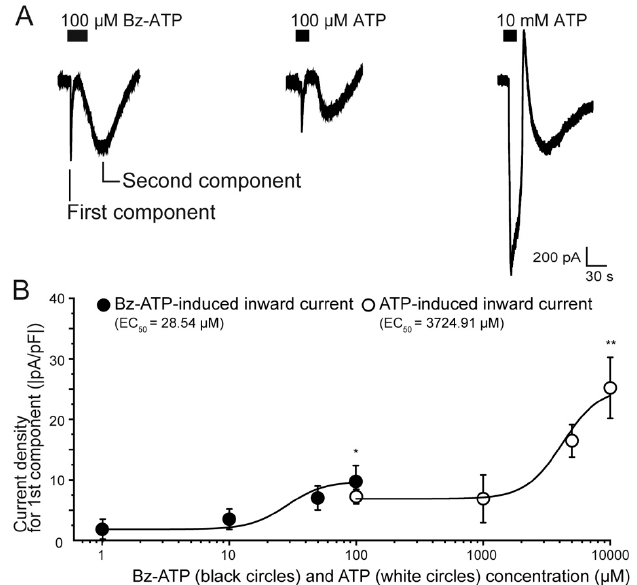
Figure 1. Characterization of primary cultured TG neurons. ( A ) Traces illustrate whole-cell currents evoked by a sequence of 10-ms depolarizing voltage pulses at Vh of − 60 mV in 10 mV increments from − 80 to +100 mV. The upper traces show the voltage pulse protocol. The middle traces were obtained from the cell in which the voltage-dependent inward currents were generated, and the lower traces were the cells in which the inward currents were not observed. Cells in which the generated inward current was observed were identified as neurons in the TG cells. ( B ) Current-voltage (I–V) relationships were obtained by plotting the values of the peak current densities against the applied membrane potentials. Cell size was determined by normalizing the measured capacitance and expressing current amplitudes in terms of current densities (pA/pF). At a Vh of − 60 mV, black squares show an inward current developed at a membrane potential of − 30 mV and reached maximum densities at − 10 mV, leading to the identification of TG neurons. White circles show the I–V relationships with cells showing no inward current. Each data point represents the mean ± S.D. of the 32 experiments for the cells showing inward current and 12 experiments for cells not showing it.